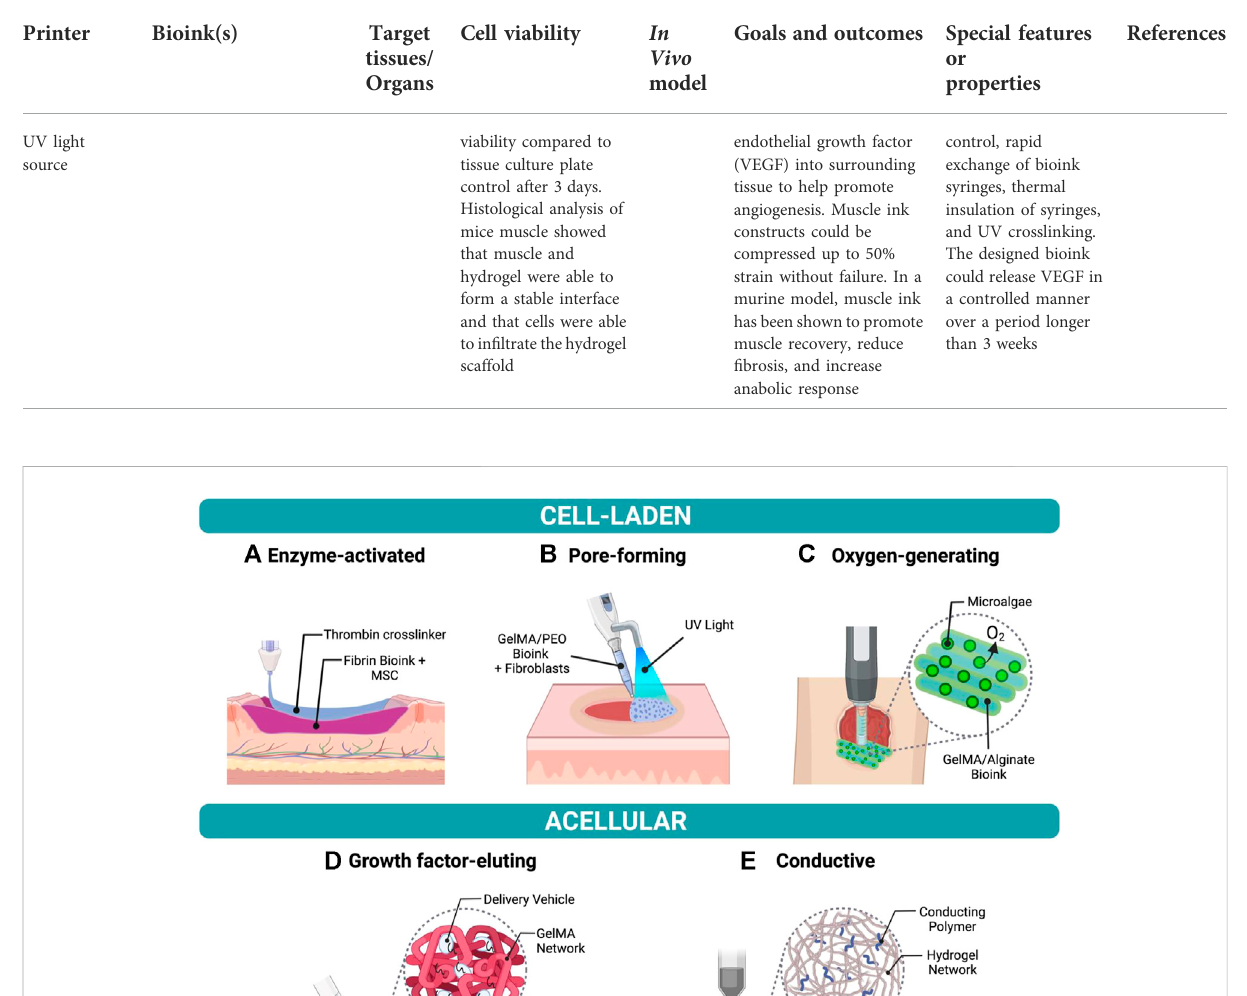
TABLE 2 ( Continued ) In situ 3D bioprinting — hand-held bioprinting.